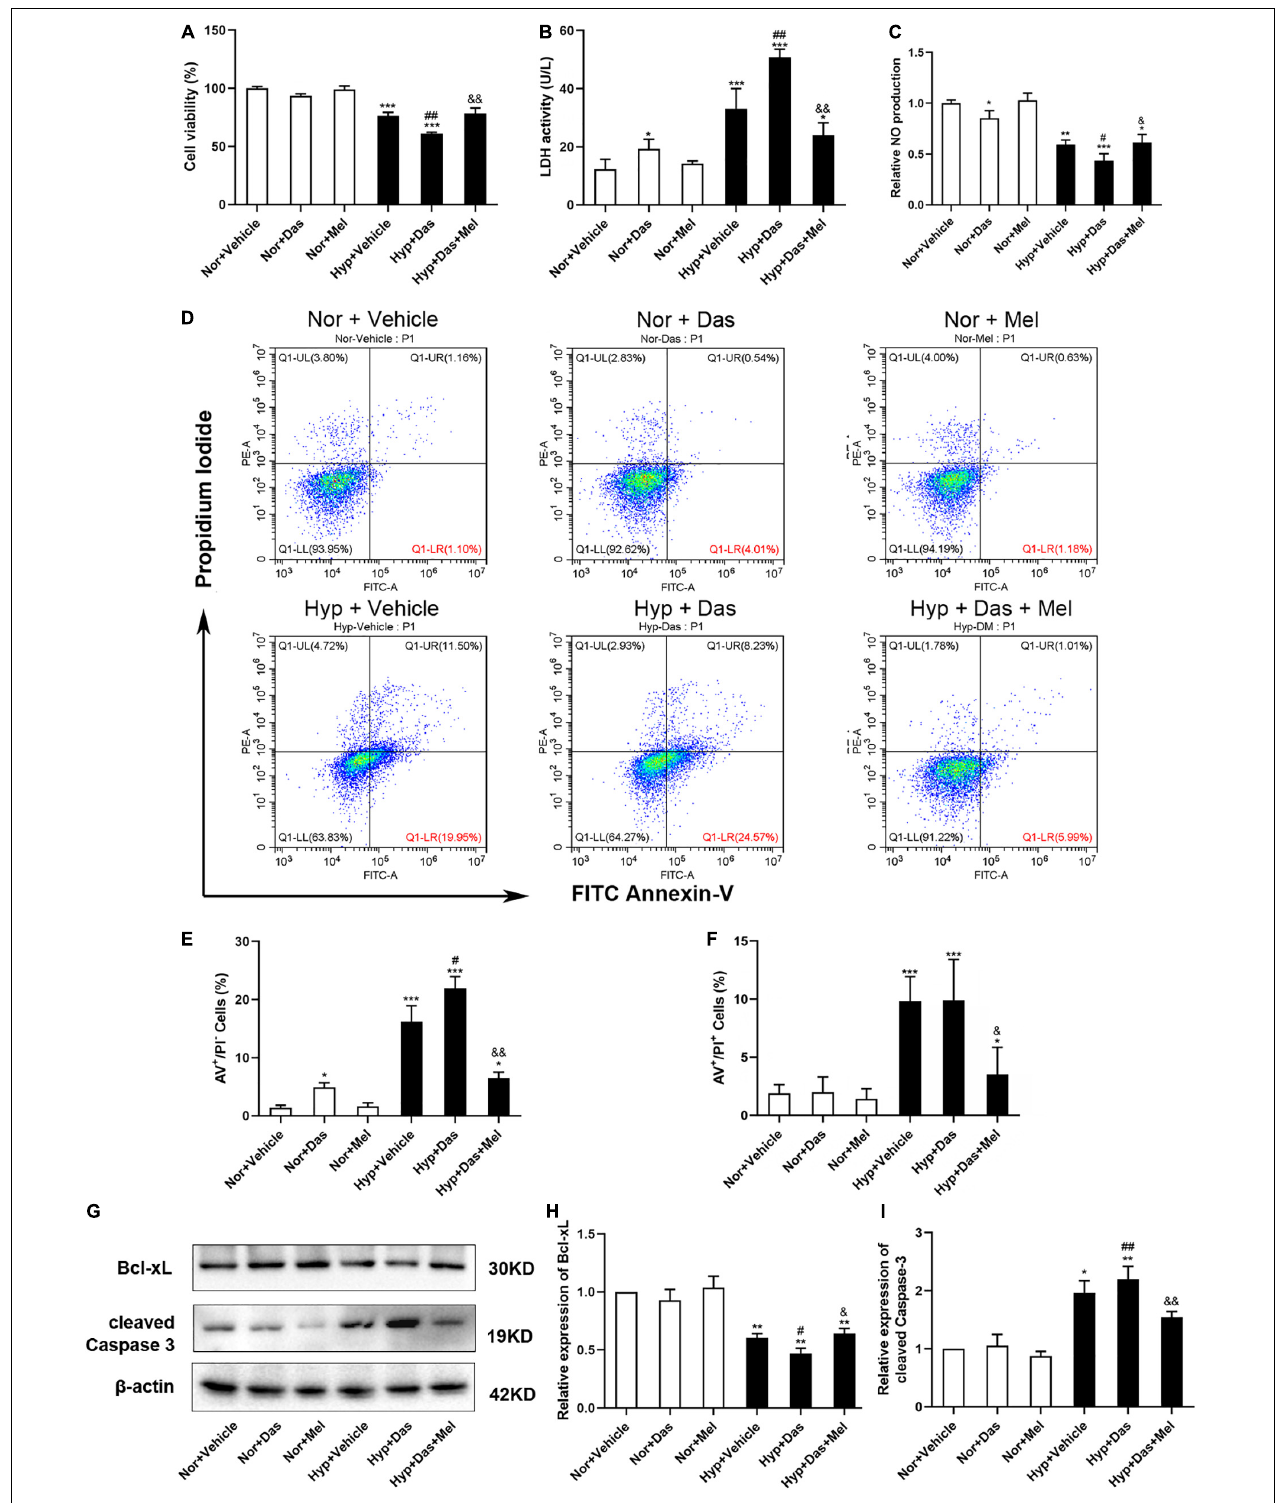
FIGURE 6 | Melatonin protects human pulmonary endothelial cells (HPMECs) from dasatinib-induced apoptosis under hypoxia. Cell viability detected with cell counting kit-8 assay (A) , LDH activity in the medium (B) ( n = 6), Relative NO production (C) ( n = 4), Representative FACS dot plots of annexin V (AV) and propidium iodide (PI) dual labeling in HPMECs (C) , quantification of AV and PI dual labeling in HPMECs (D–F) . Protein expression of Bcl-xL and cleaved Caspase-3 in HPMECs (G) . Bar graph shows the statistic results of Bcl-xL, cleaved Caspase-3 protein levels (H,I) ( n = 3). Values are means ± SEM, ***P < 0.001, **P < 0.01, *P < 0.05 compared with Nor + Vehicle group. ## P < 0.01, # P < 0.05 compared with Hyp + Vehicle group. && P < 0.01, & P < 0.05 compared with Hyp + Das group.